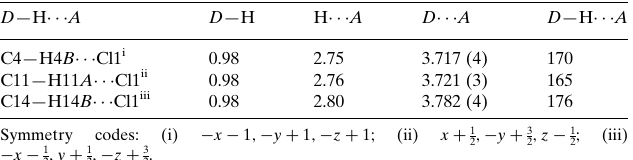
Hydrogen-bond geometry (A ˚ , (cid:2)